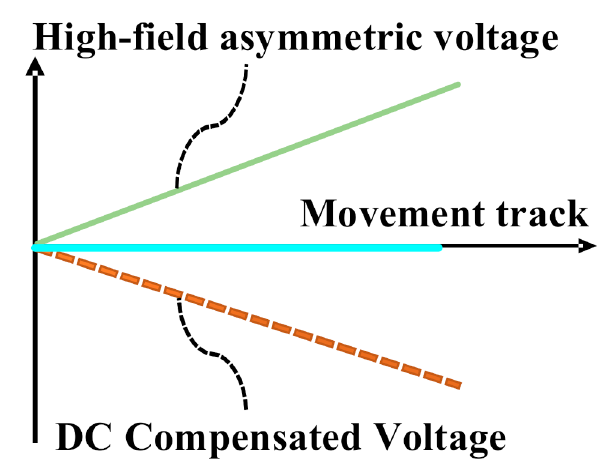
Figure 6. The trajectory of the ions under the action of the compensation voltage and high asymmetric